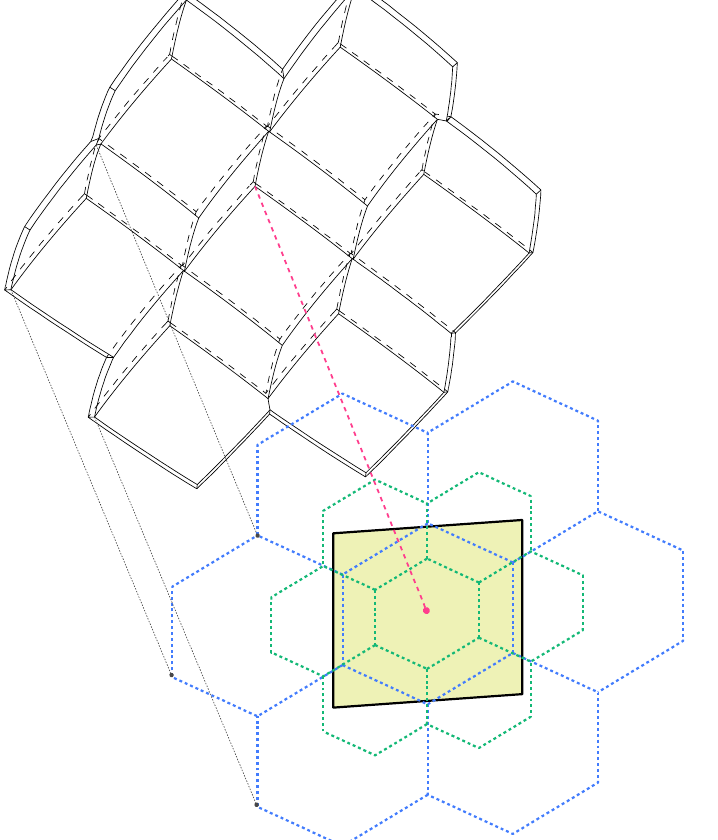
Figure 4. The seven large parabolic trihedron array and its shadow on the source-receiver plane (blue). The shadow of the small array is also shown (green). Single trihedron cases only use the one in the respective array center. Sources are within the yellow area (2.4 × 2.4 m). The red dotted line traces the central source-to-vertex distance, which was extended for clarity.